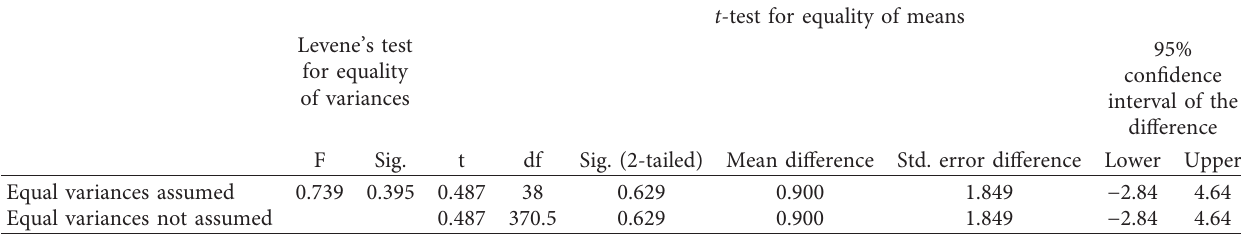
Table 3: Results of independent sample t -test (pretest).